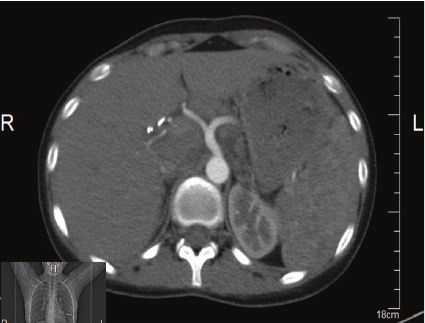
Figure 4: Thoracic CT